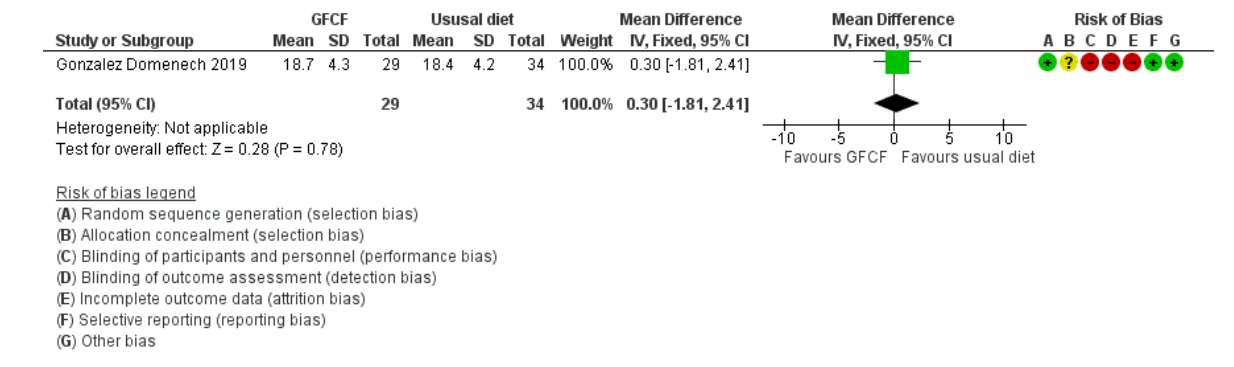
Figure 9. Forest plot of comparison: GFCF vs. usual diet, outcome: body mass index.